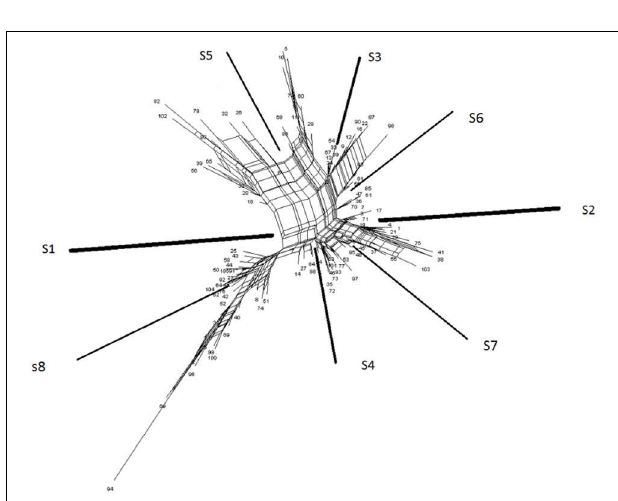
FIGURE 7 | An example of an outer planar network showing the eight splits of the eight parameters